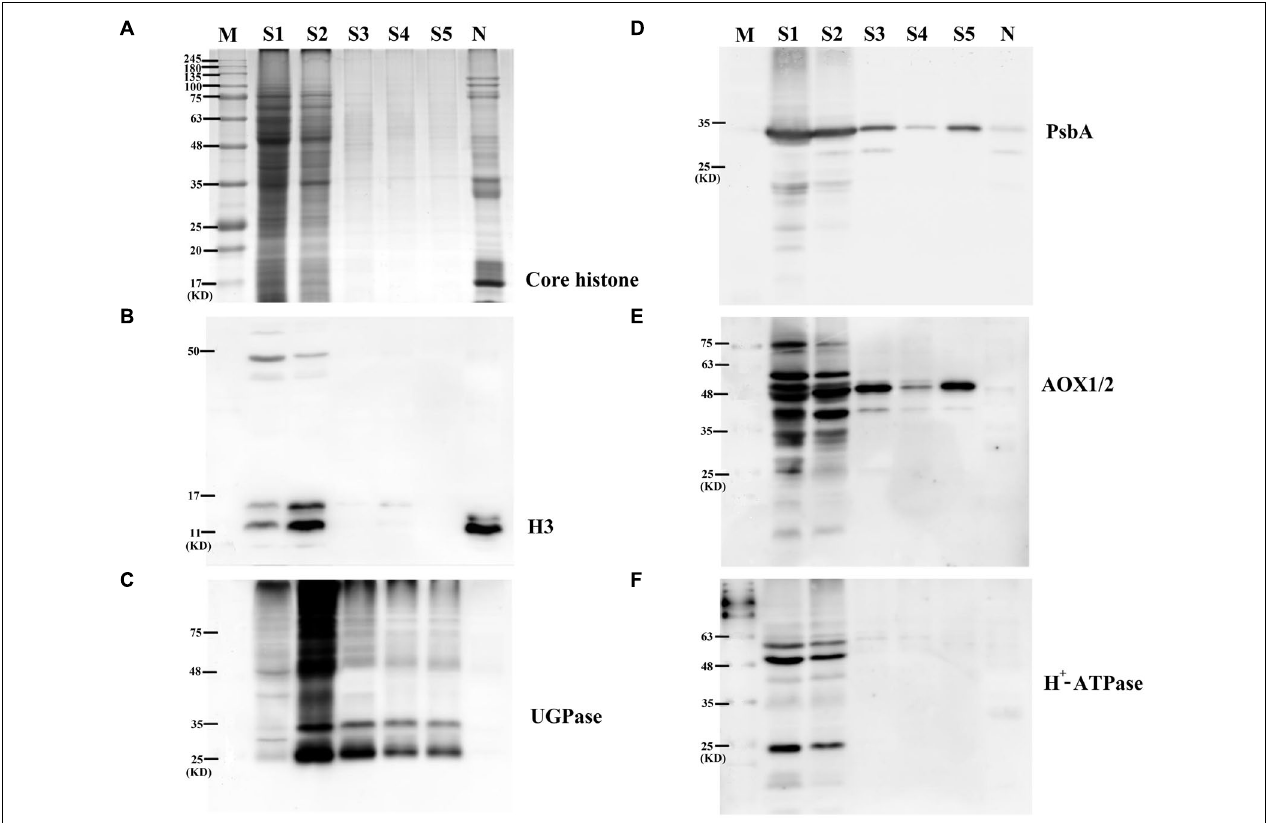
FIGURE 1 | Enrichment and purity assessment of nuclear proteome from wheat developing grains. (A) Analytical 1-D electrophoresis profile (12.5% SDS-PAGE, CBB staining) of protein content in different stages of nuclei enrichment progress. (B) Immunoblot analysis with anti-histone H3. (C) Immunoblot analysis with anti-vacuolar UGP. (D) Immunoblot analysis anti-photosystem PsbA. (E) Immunoblot analysis with anti-AOX. (F) Immunoblot analysis with anti-H + -ATPase. S1–S5, five supernatant samples (S1–S5) collected during the washing process of nuclear precipitation; N, extracted nuclei